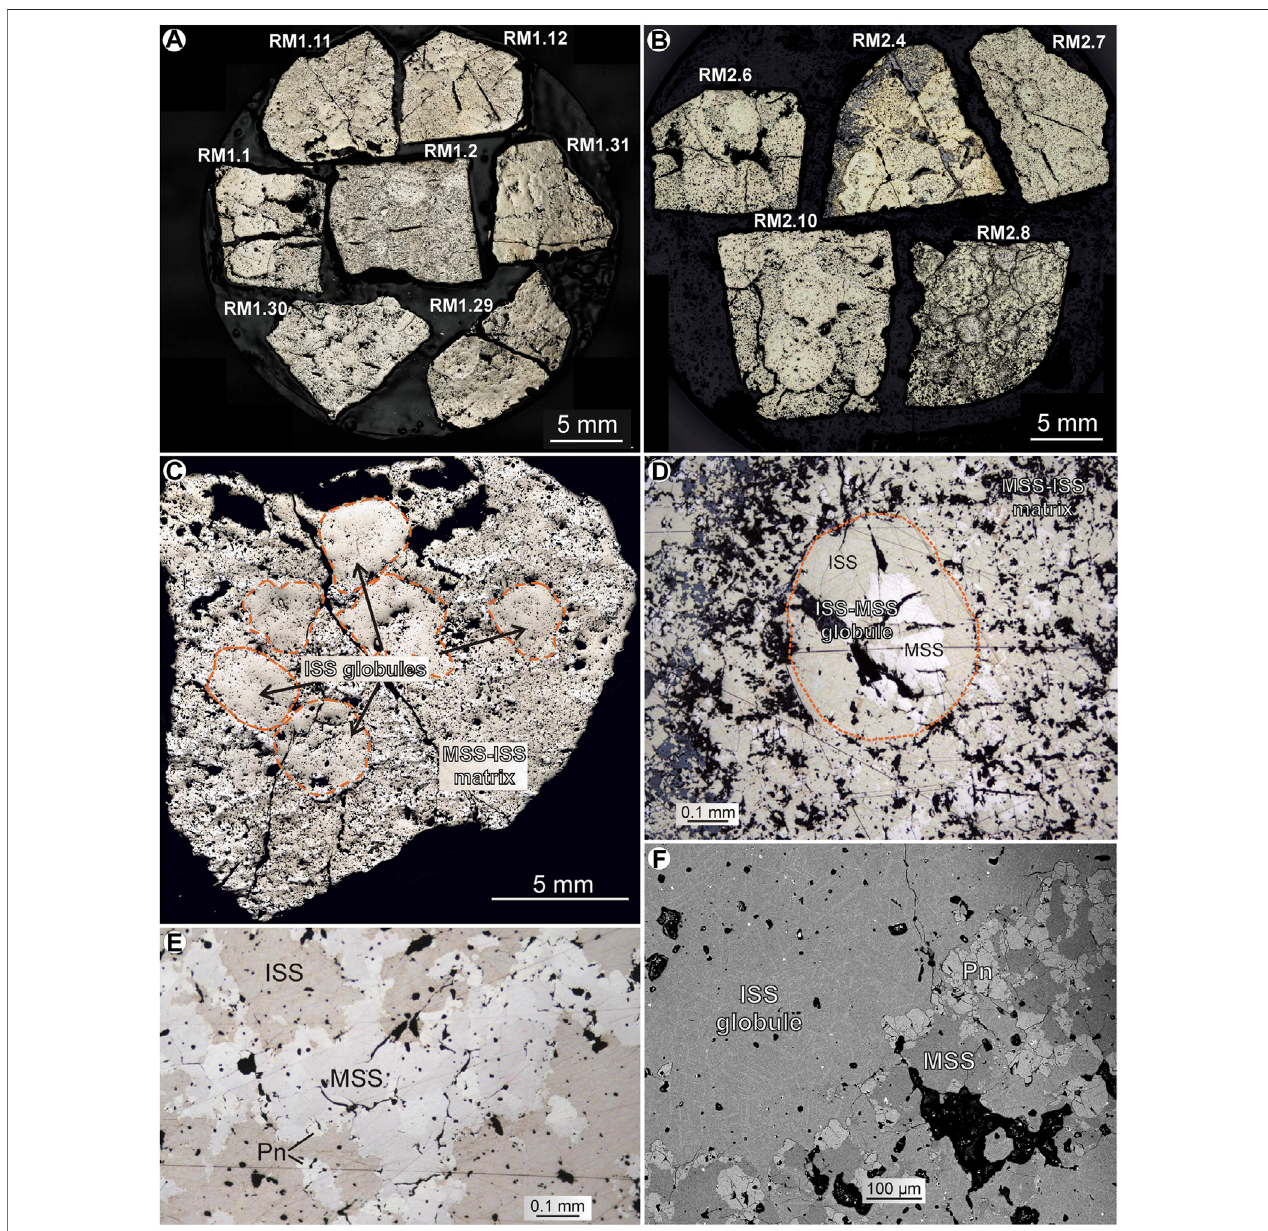
FIGURE2| Microphotographsofinvestigatedsamples; (A) :sampleRM1; (B) :sampleRM2; (C,D) :atypicaltextureofsamples-ISSglobulesinanMSS-ISSmatrix andISS-MSSglobuleinMSS-ISSmatrix(c — RM1.1,d — RM1.2)(c — RM1.1,d — RM1.30). (E) :MSS-ISSmatrixwithpentlanditegrainsatthecontactbetweenMSSand ISS (RM1.29). (F) : an edge of the ISS globule in BSE (RM1.29); Pn — pentlandite.